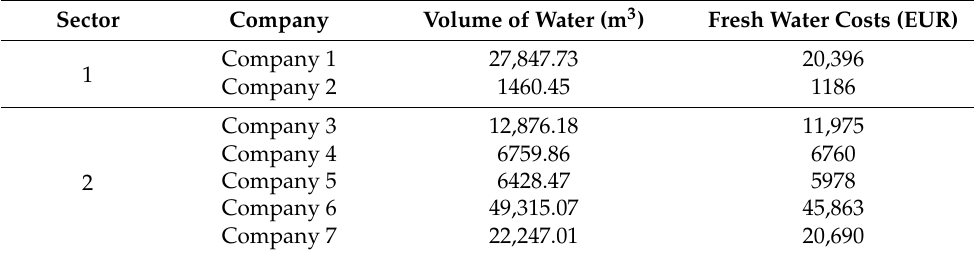
Table 7. Quarterly fresh water costs according to consumption and tariffs.